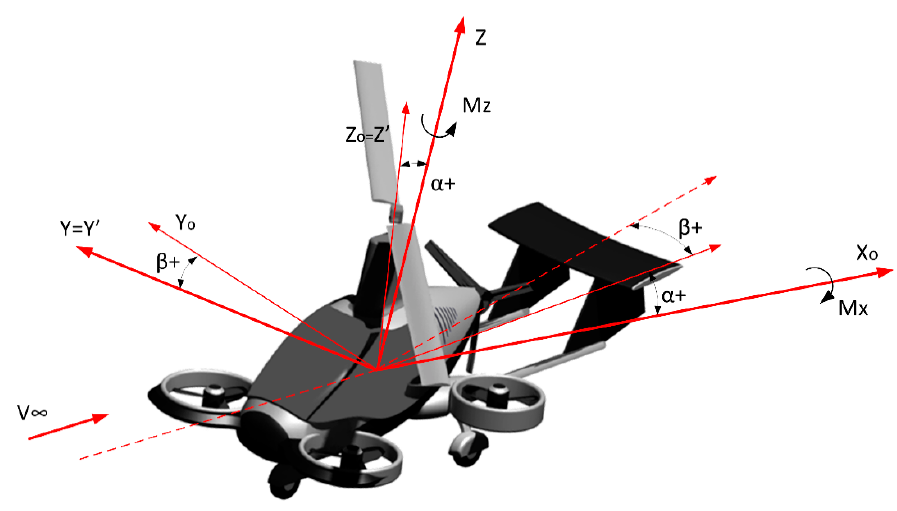
Figure 3. The adopted reference system associated with the flow.